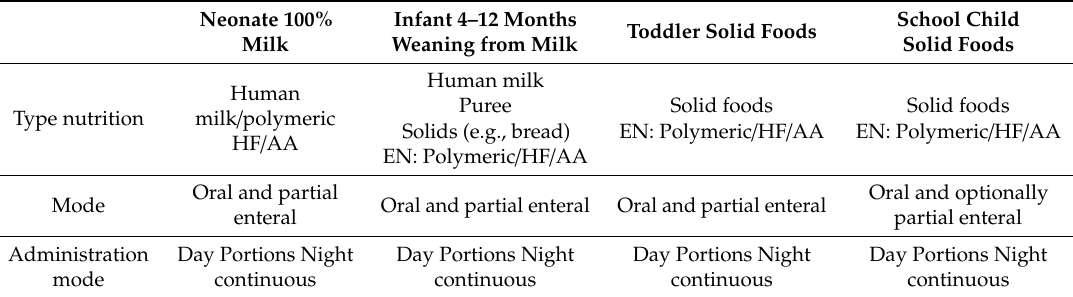
Table 1. Age appropriate oral / enteral feeding